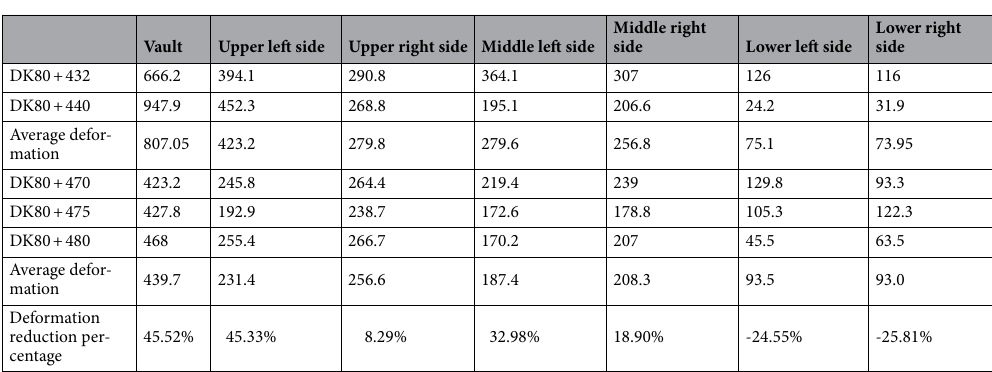
Table 4. Comparison of the surrounding rock convergence between the two construction methods (all values in